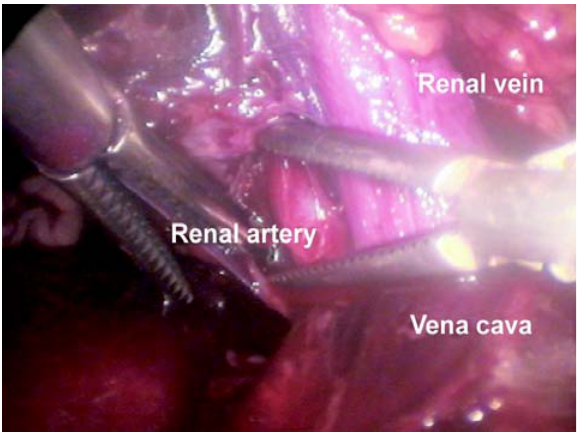
Figure 3 – Position of the trocars. Figure 4 – Identification of the renal